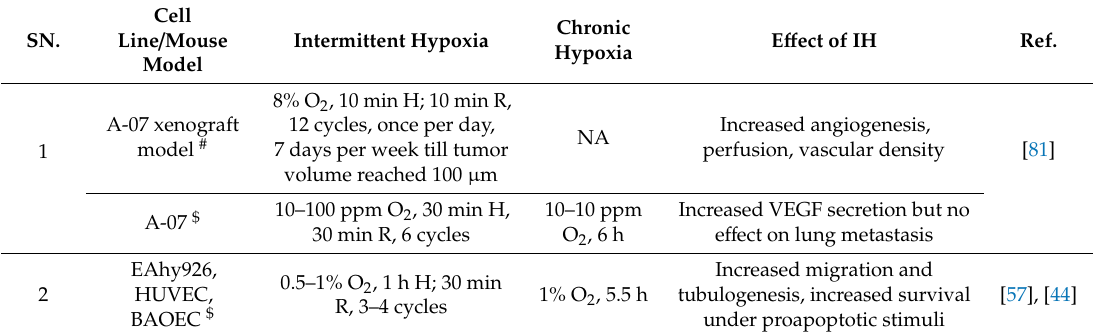
Table 3. E ff ect of intermittent hypoxia (IH) on